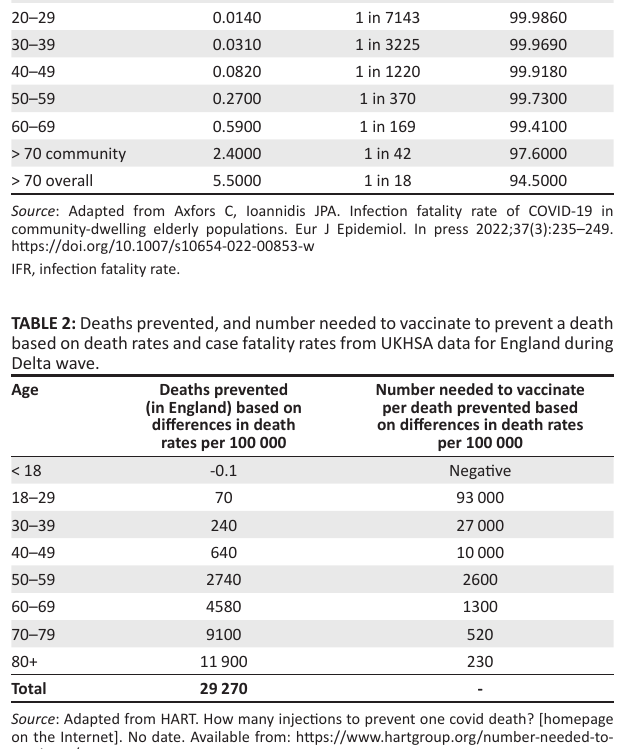
Source : Adapted from HART. How many injections to prevent one covid death? [homepage on the Internet]. No date. Available from: https://www.hartgroup.org/number-needed-to- vaccinate/ UKHSA, United Kingdom Health Security